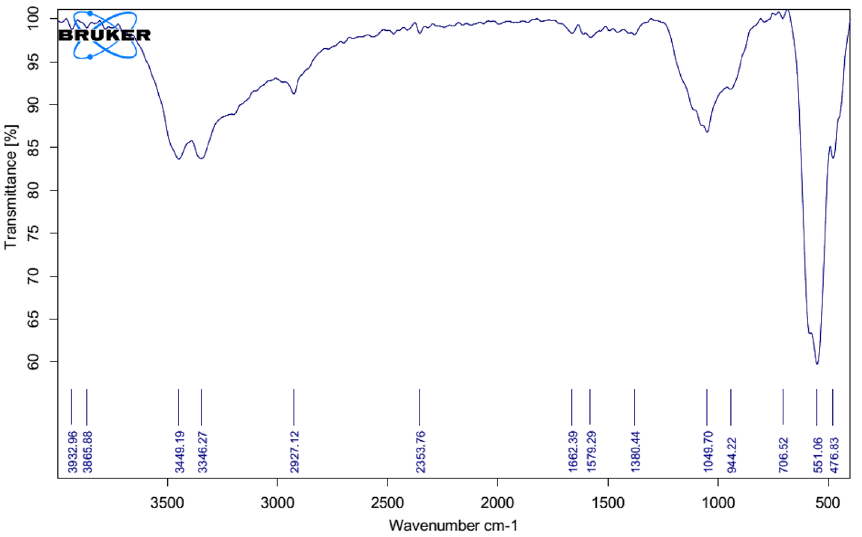
Figure 2. FT-IR spectra of Zn-doped CuFe 2 O 4